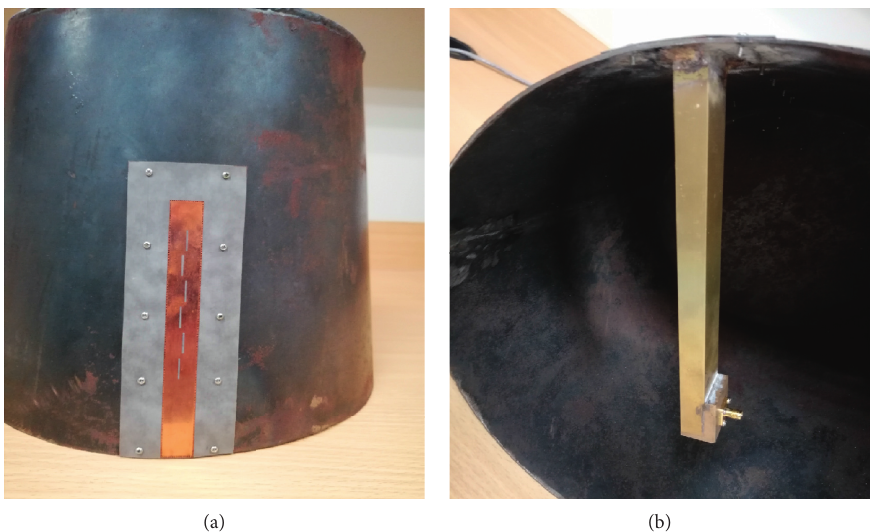
Figure 11: Prototype of the fabricated nose-cone conformal slot array antenna. (a) Slotted array conformed on conical platform. (b) Rectangular waveguide with SMA connector.